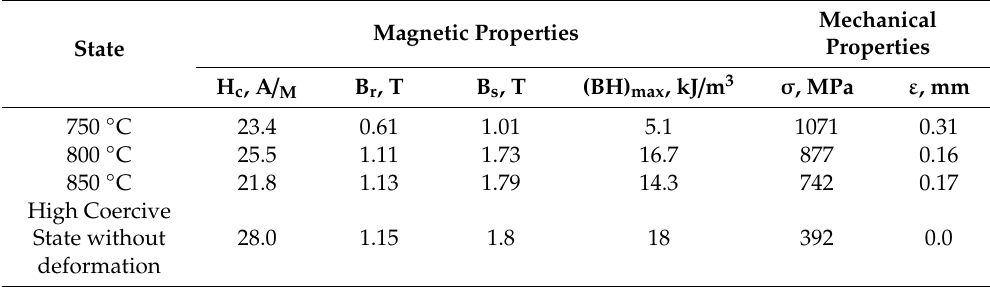
Table 1. Magnetic properties (coercive force H c , residual induction B r , saturation flux density B s , magnetic product (BH) max ) and mechanical properties (maximum stress σ , size of deflection ε ) of the deformed alloy after magnetic treatment and three-point bending